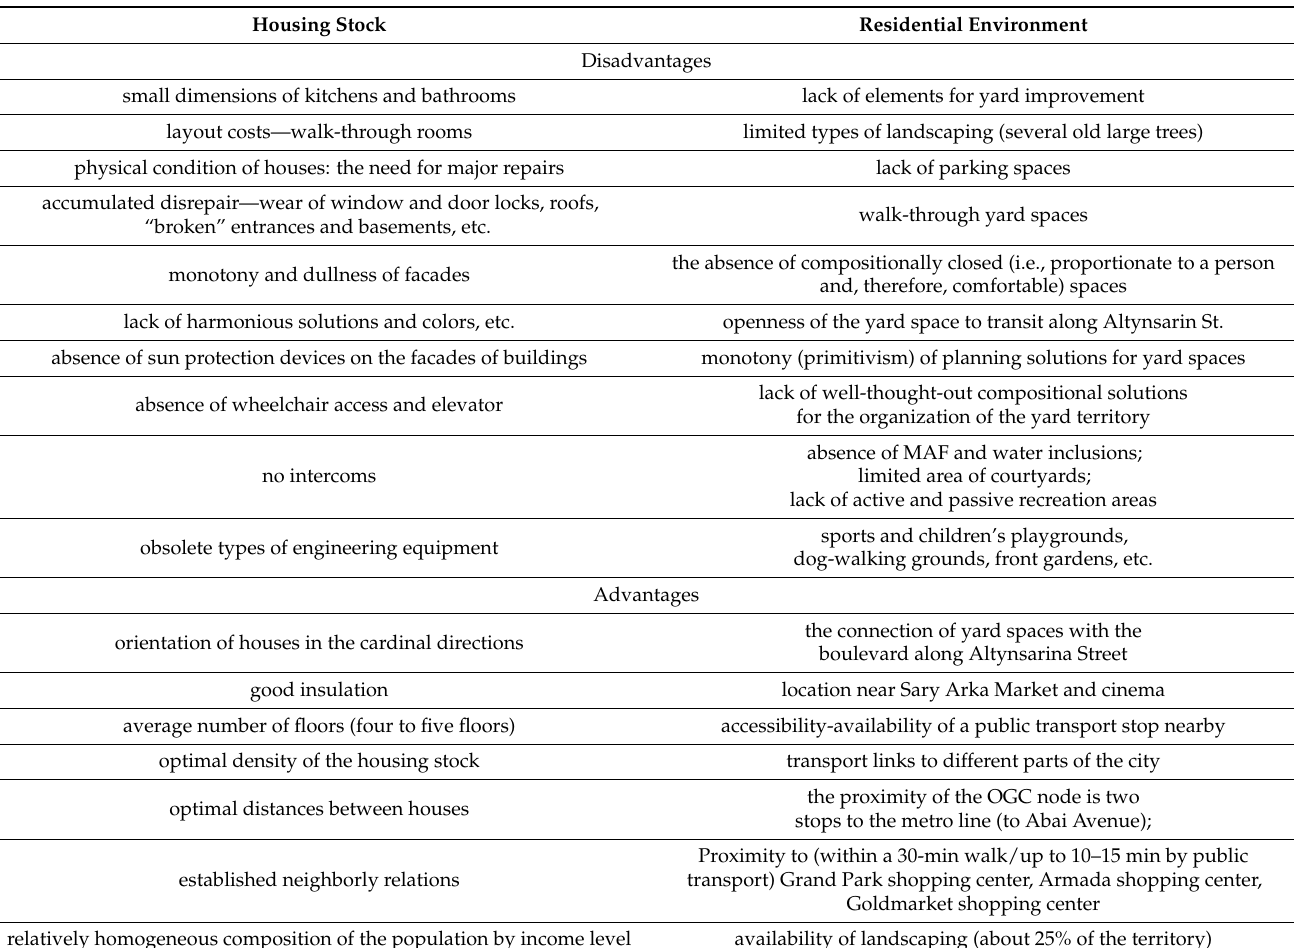
Table 1. Pre-project